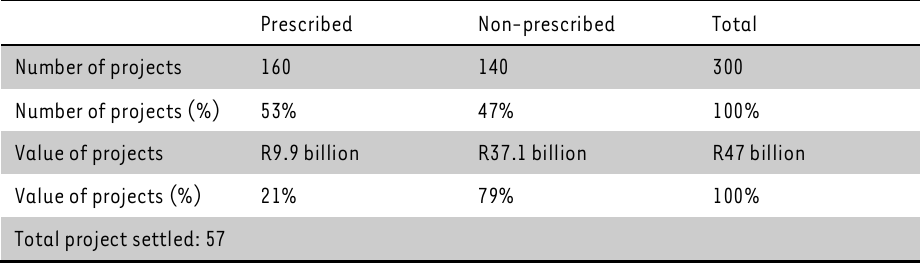
Projects affected by the construction cartel: Prescribed versus Non-prescribed Prescribed Non-prescribed Total Number of projects 160